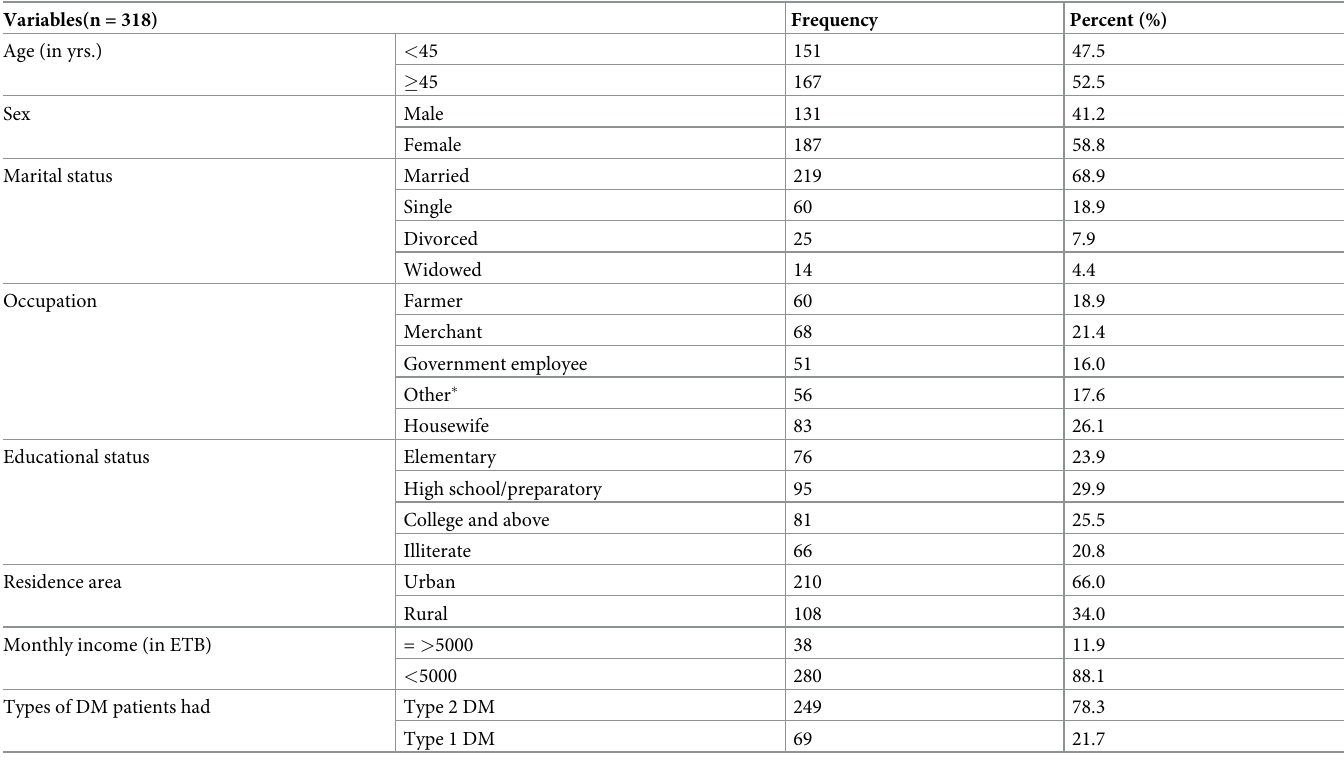
Table 1. Socio-demographic characteristics of patients with diabetic mellitus who were on follow-up at Jimma University Medical Centre, 2021. Variables(n = 318) Age (in